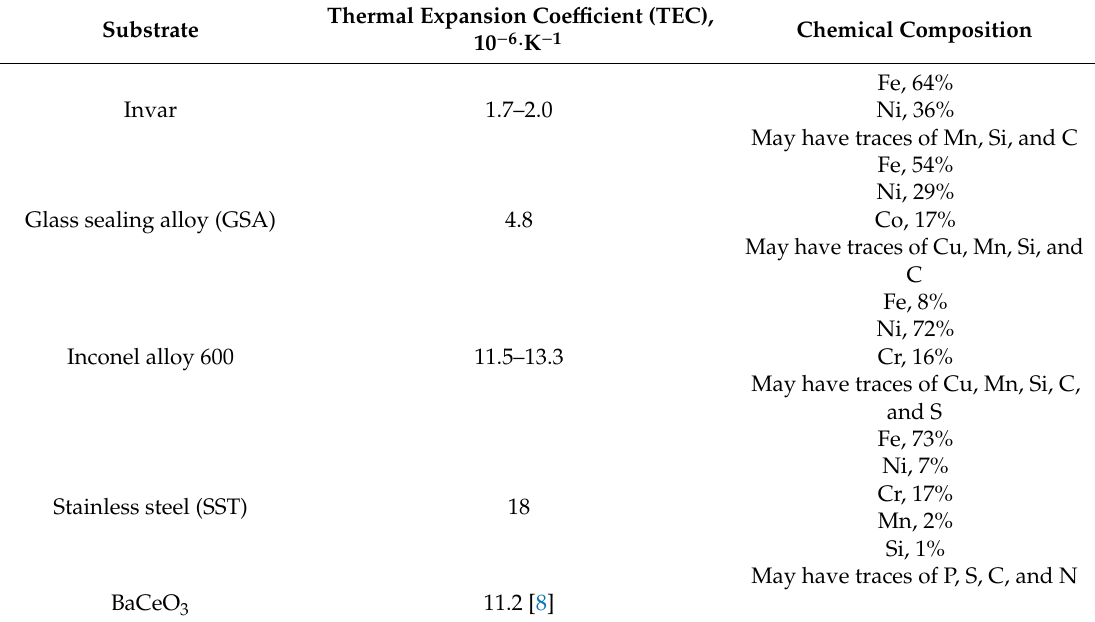
Table 1. Composition of the di ff erent substrates and barium